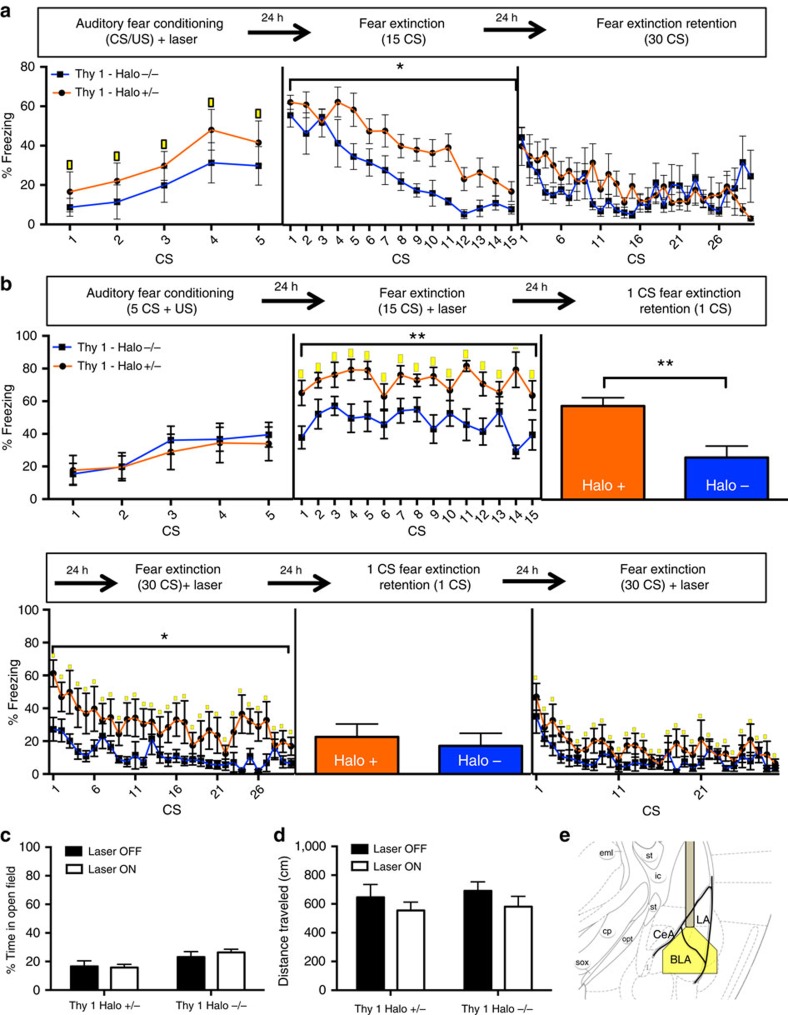
In vivo inhibition of Thy1 neurons.Inhibition of Thy1 neurons enhances fear consolidation and fear expression, while blunting fear extinction consolidation. BLA neurons of mice expressing halorhodopsin under the control of the Thy1.2 expression cassette were silenced during select phases of fear conditioning to determine their precise role in behaviour. This change in fear behaviour was not caused my changes in anxiety-like behaviour. (a) Silencing BLA Thy1 neurons during weak fear acquisition results in no significant within-session changes in behavior; however, 24-h later mice carrying the Thy1-halorhodopsin gene express significantly more fear during fear extinction (two-way Repeated measures (RM) ANOVA, F(1,14)=5.827 ,*P<0.05). (b) Mice weakly fear conditioned in the absence of laser stimulation show no within-session behavioral differences; however, 24-h later when laser stimulation is applied during CS-on period of extinction, mice carrying the Thy1-halorhodopsin gene express significantly more fear (two-way RM ANOVA, F(1,12)=10.08,**P<0.01). Thy1-halorhodopsin carrying mice exhibit significantly enhanced fear 24-h later in the absence of laser stimulation (Student's t-test, **P<0.01). 24-h later, enhanced freezing is measured throughout the extinction retention session when laser stimulation is provided during CS-on period (two-way RM ANOVA, F(1,11)=7.75, *P<0.05). 24-h later no difference in freezing to CS is detected in the absence of laser stimulation. A final extinction session with laser stimulation during CS presentation reveals no differences in freezing. (c) Inhibition of BLA Thy 1 neurons was not accompanied by any change in anxiety-like behavior or (d) ambulation. Thy1-halorhodopsin carriers spent the same amount of time in the centre of an open field as controls whether laser light was on or off. Thy1-halorhodopsin carriers travelled the same distance whether laser light was on or off. (e) Schematic of optical fibre placed dorsal to the BLA providing yellow laser illumination during experimental procedures. Light is estimated to maintain >10 mW power within 0.5 mm of the fibre optic tip. In all panels error bars indicate mean±s.e.m.